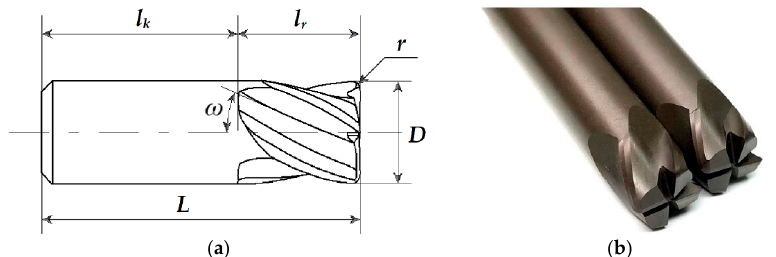
Figure 2. Drawing ( a ) and general view ( b ) of experimental samples of solid ceramic end mills made by the team of authors. Table 1. The geometric design of solid ceramic end mills for development and testing purposes. Tool Parameter